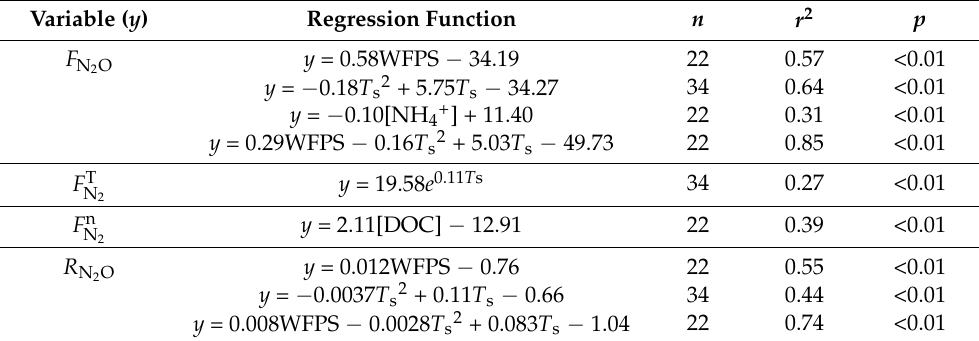
) and nitrous oxide ( F N ) measured by using the 15 N gas flux N 2 2 O to F N plus F T ( R N ) against soil factors. N 2 2 O 2 O 2 O